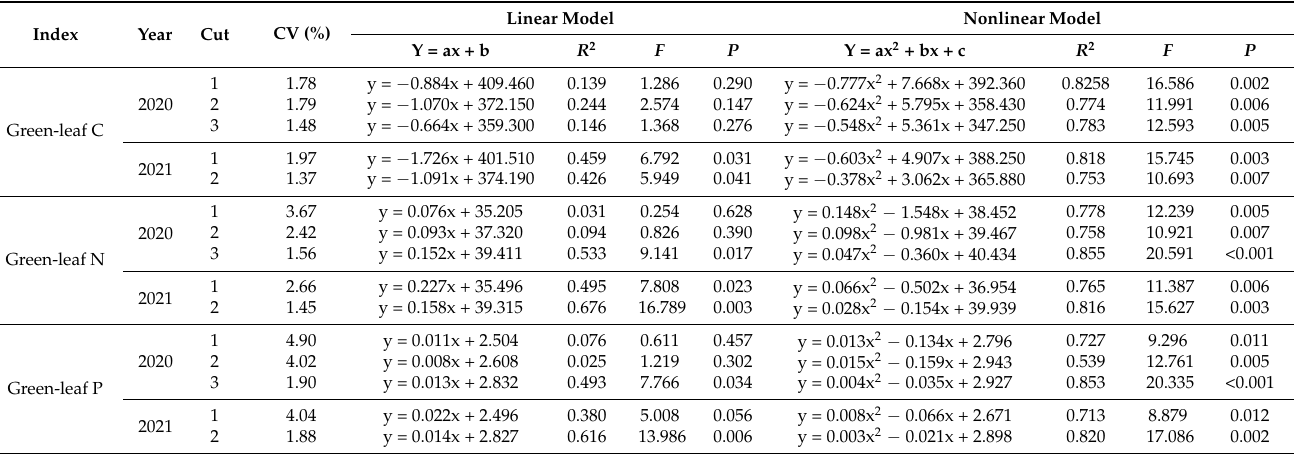
Table 2. Correlation analysis between fall-dormancy levels and C, N, and P concentrations in mature alfalfa leaves